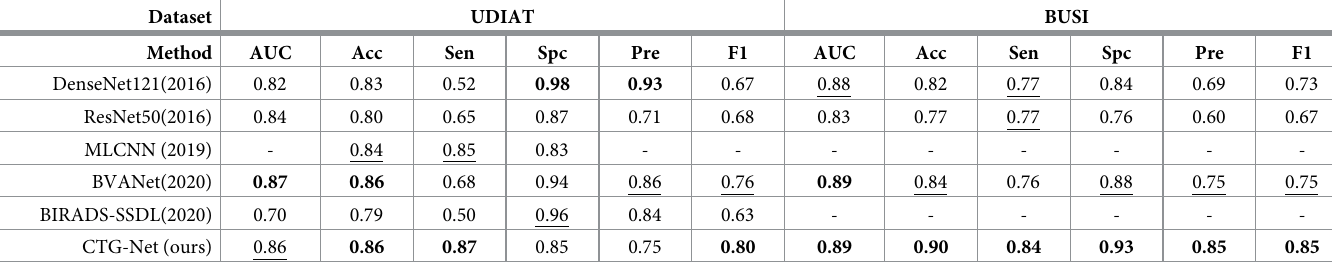
The best results are indicated in boldface and the second-best results are